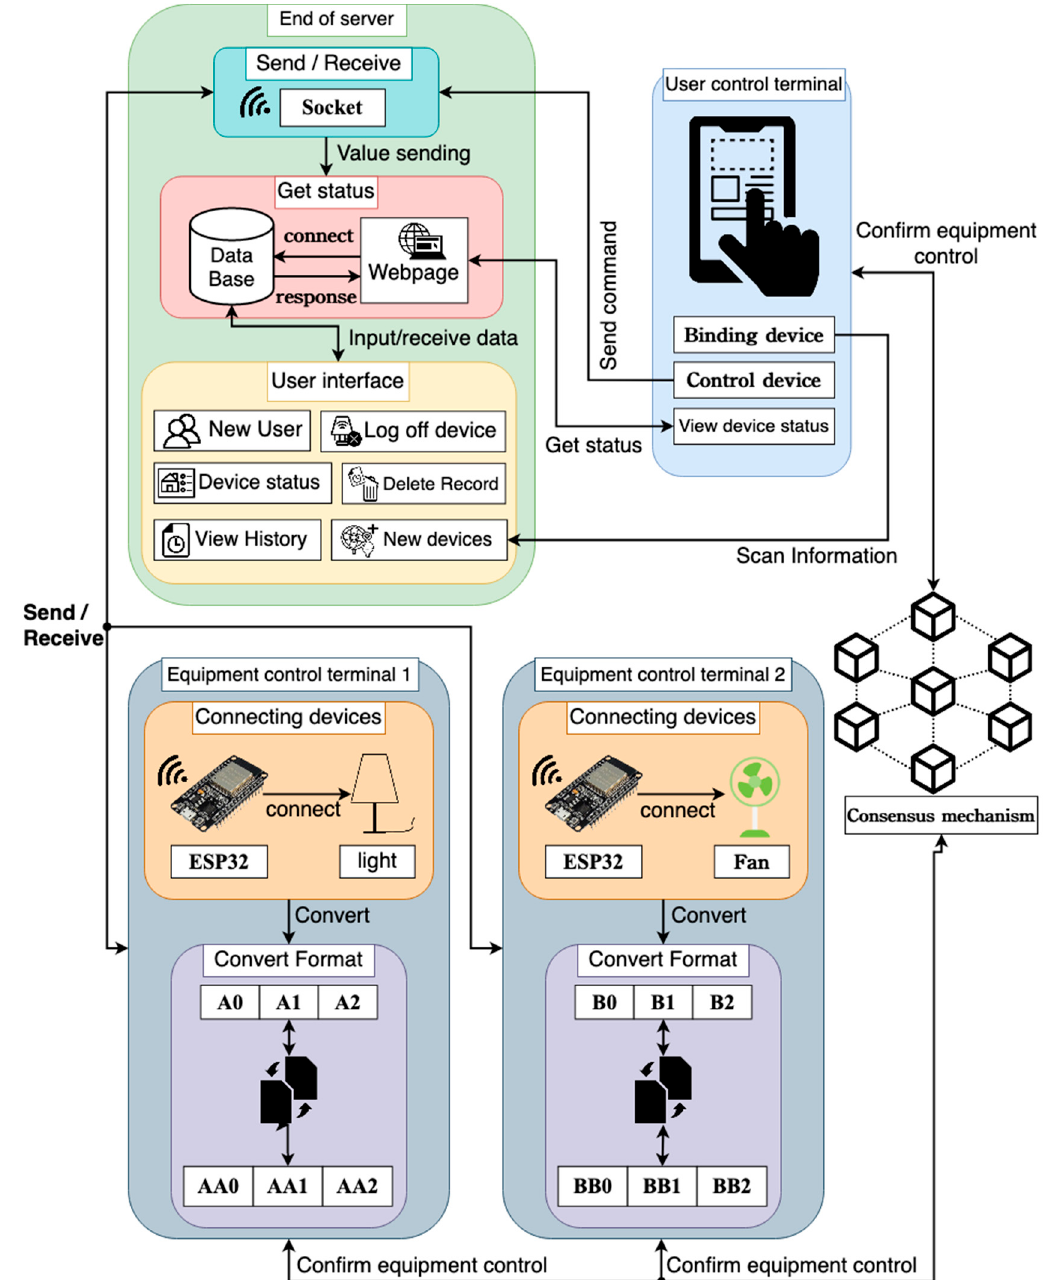
Figure 2. Module connection